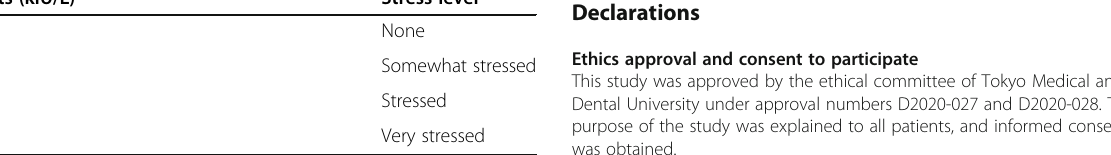
Table 5 Reference values for salivary alpha-amylase Results